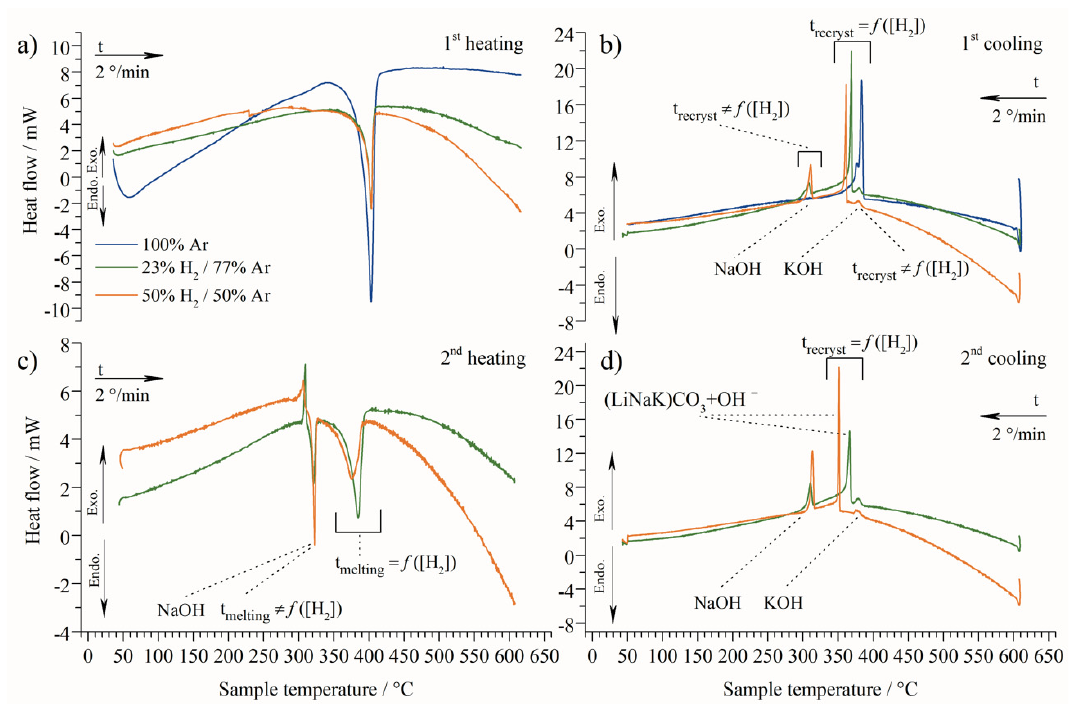
Figure 5. DSC signals observed for SDC—LiNaK electrolyte powder as function of sample tem- perature in pure Ar, 23%— and 50%—H 2 —in—Ar gas mixtures at atmospheric pressure. The first heating/cooling cycle ( a , b ) was followed by second one ( c , d ) for the same sample. Scanning rate was two degrees per minute and its direction is indicated by arrows. Table 2. Transition temperature (t onset ) dependence on H 2 percentage in Ar for SDC—LiNaK elec- trolyte powder detected by DSC studies during one or two heating/cooling scanning cycles. All peaks are endothermic during heating if the opposite is not indicated; all peaks are exothermic during each cooling stage.